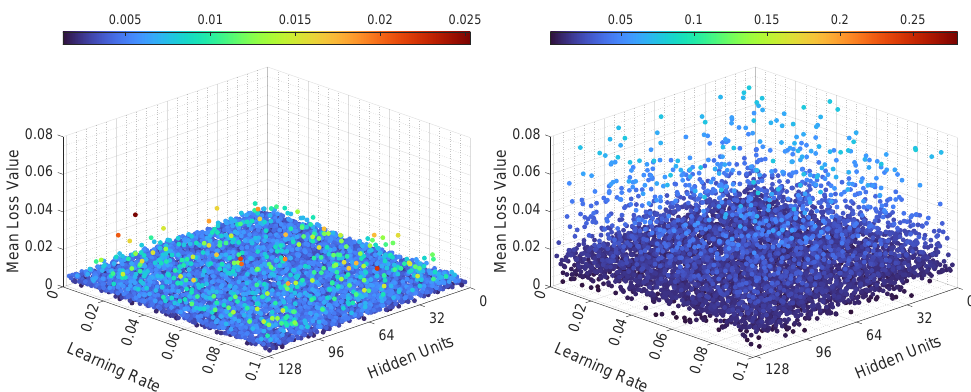
Figure 22. Illustration of the mean loss value for Experiment 3, LSTMTF ( left ) and VLSTM ( right ), using a many-to-many prediction mode.